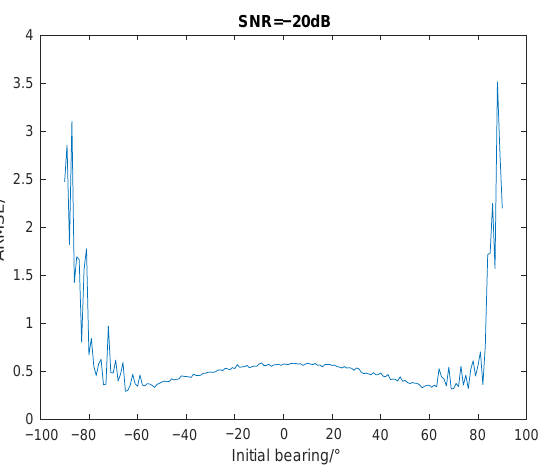
Figure 6. The variation in accuracy of bearing estimation when initial bearing is different.